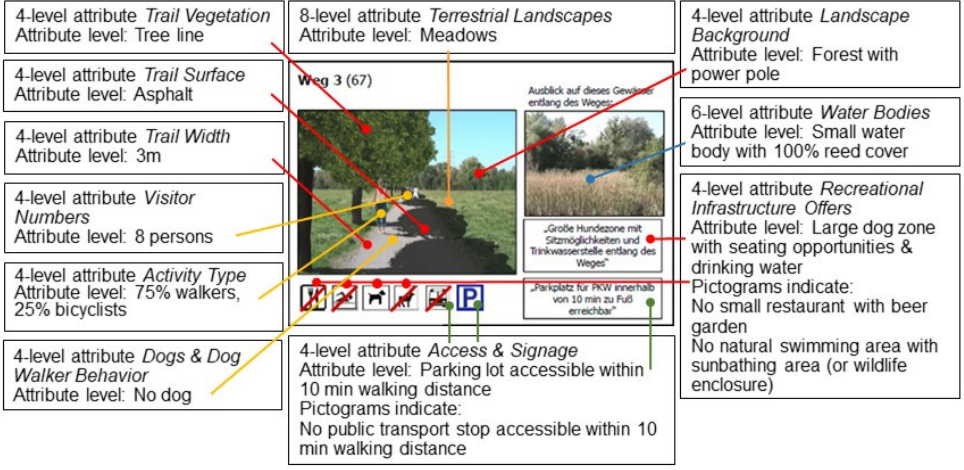
Figure 3. Example of a scenario consisting of 11 visual and pictogram assisted textual attributes with varying attribute levels used in the discrete choice experiment.